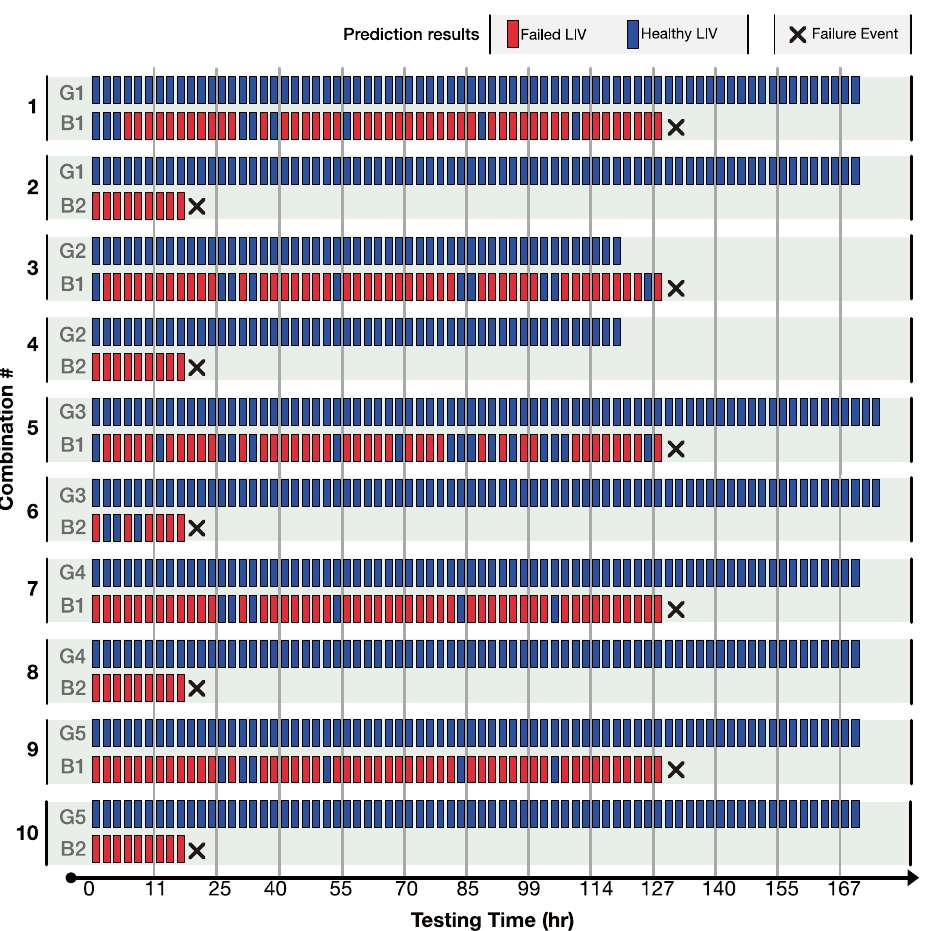
Figure 3. SVM testing results for the first stage of experiments. Rectangles represent measurement events at different time points, while their color represent the model’s prediction. The failure event is marked with a black cross. The SVM model predicts failure for all of the defective devices up to 127 h prior to the failure